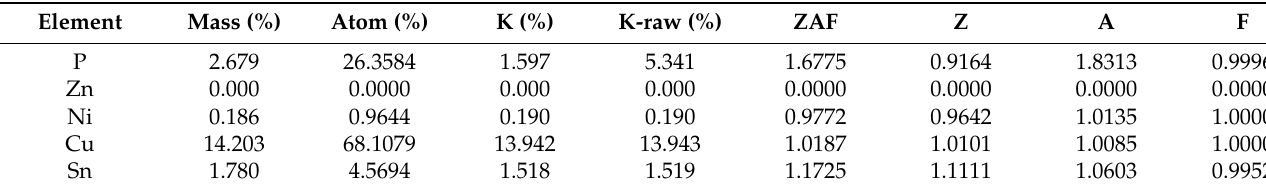
Table 3. EPMA data of the ZCuPb 20 Sn 5 alloy.